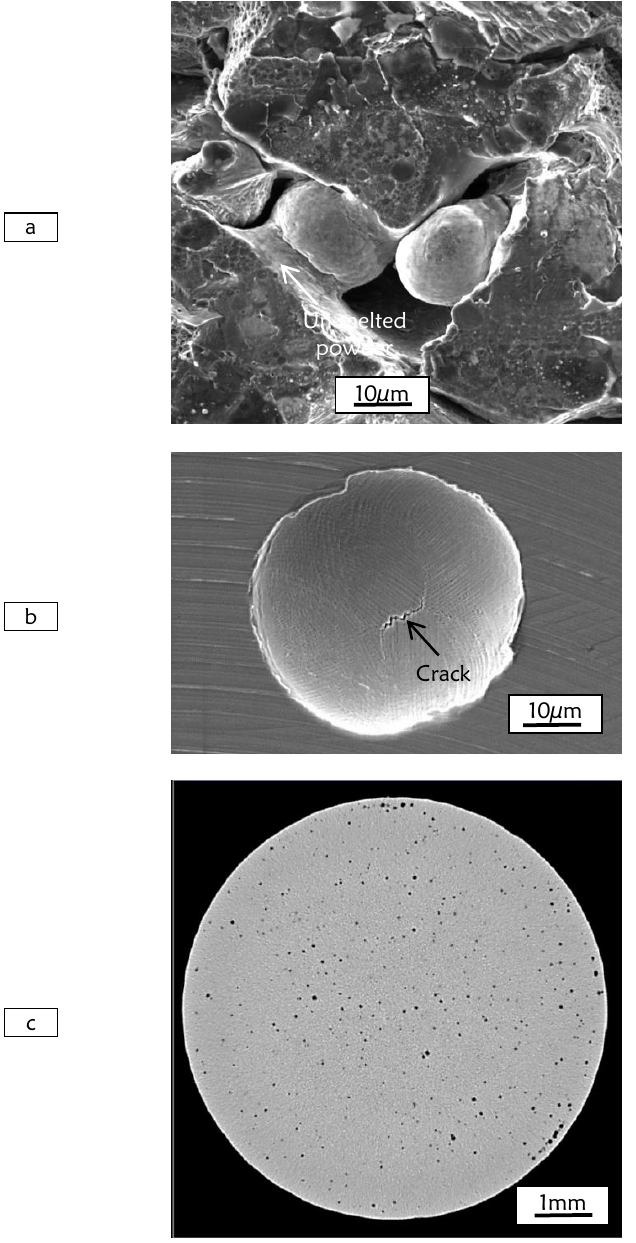
Figure 17: Defects in SLM IN718: (a) unmelted powder particles and adjacent keyhole. (b) a spherical pore sectioned by micromilling [39] and (c) distribution of pores in a cylindrical SLM IN718 bar [40]. 4 INCONEL